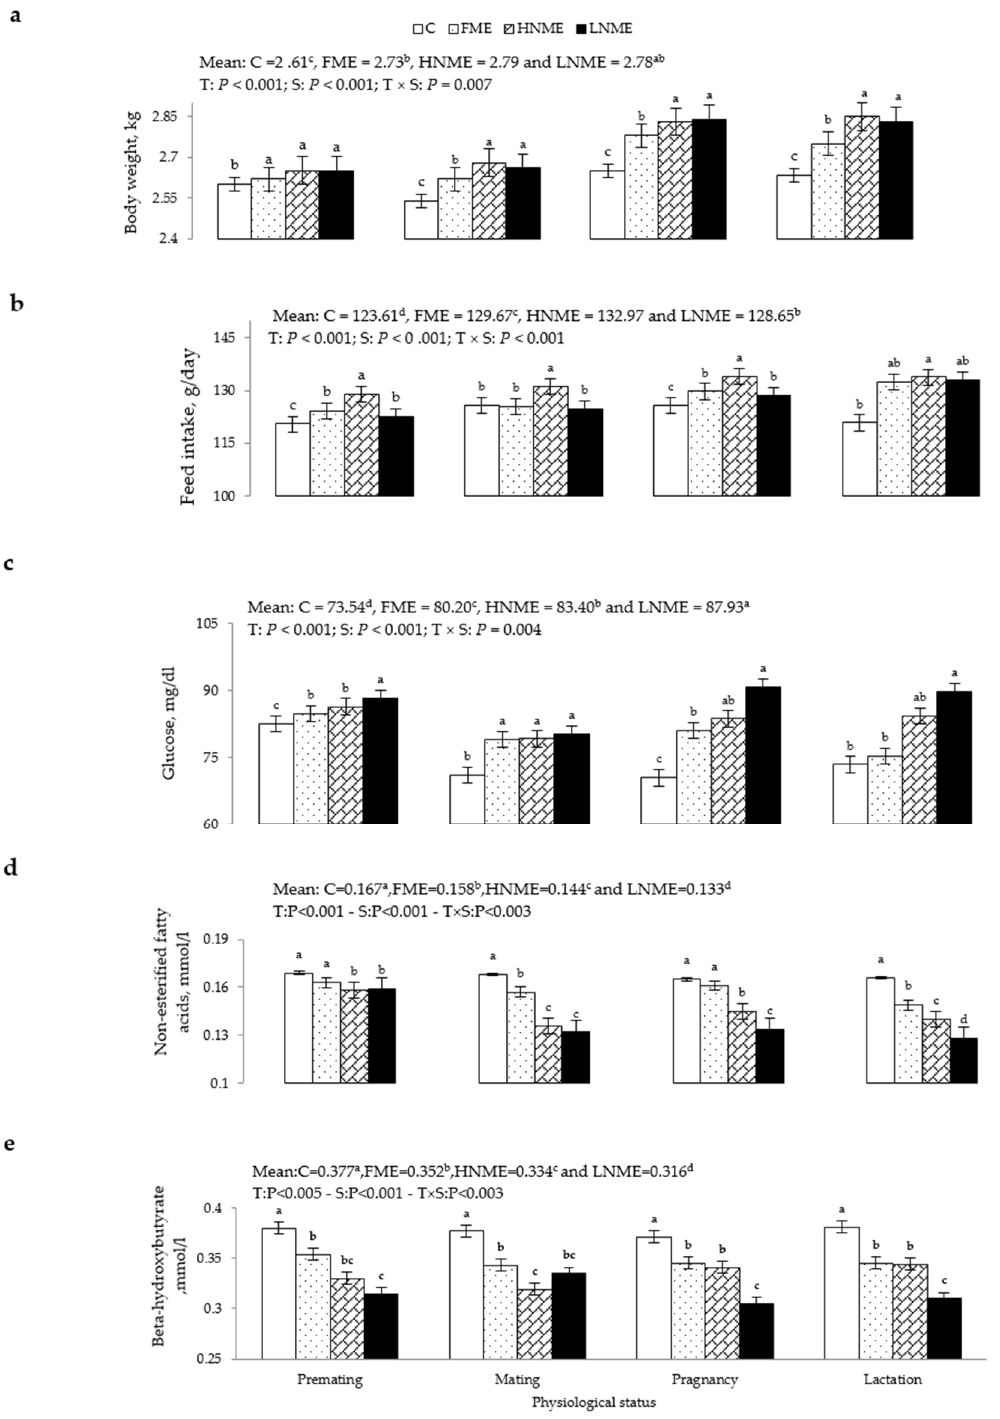
Figure 1. Means (± SEM) treatment by physiological status effects on body weight ( a ), feed intake ( b ), blood plasma glucose ( c ), non-esterified free fatty acids ( d ), and β -hydroxybutyra© ( e ) of multiparous rabbit does supplemented with 0 mg/kg BW (C), 50 mg/kg BW free ME (FME), 25 mg/kg BW nano-encapsulated ME (HNME), and 10 mg/kg BW nano-encapsulated ME (LNME). The means of different treatments within the same physiological status with different lowercase letter superscripts differ significantly ( p < 0.05).